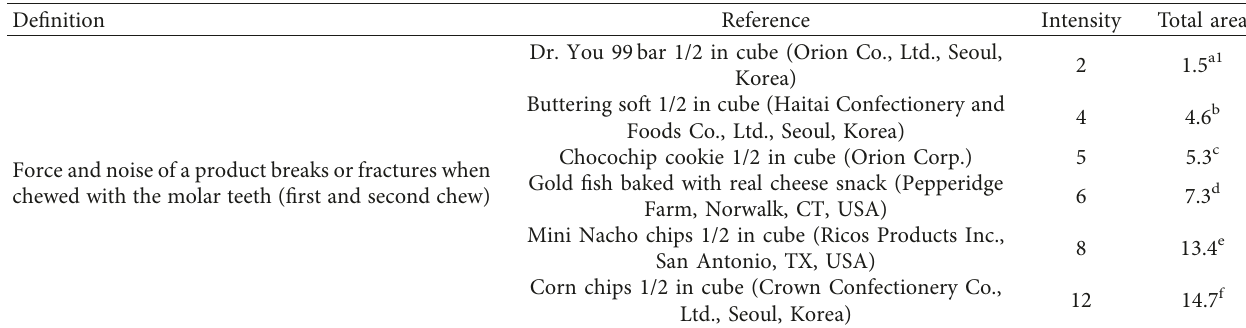
Table 3: References of crispness developed in this study for potato chips and means of total area (TA) for the references. Definition